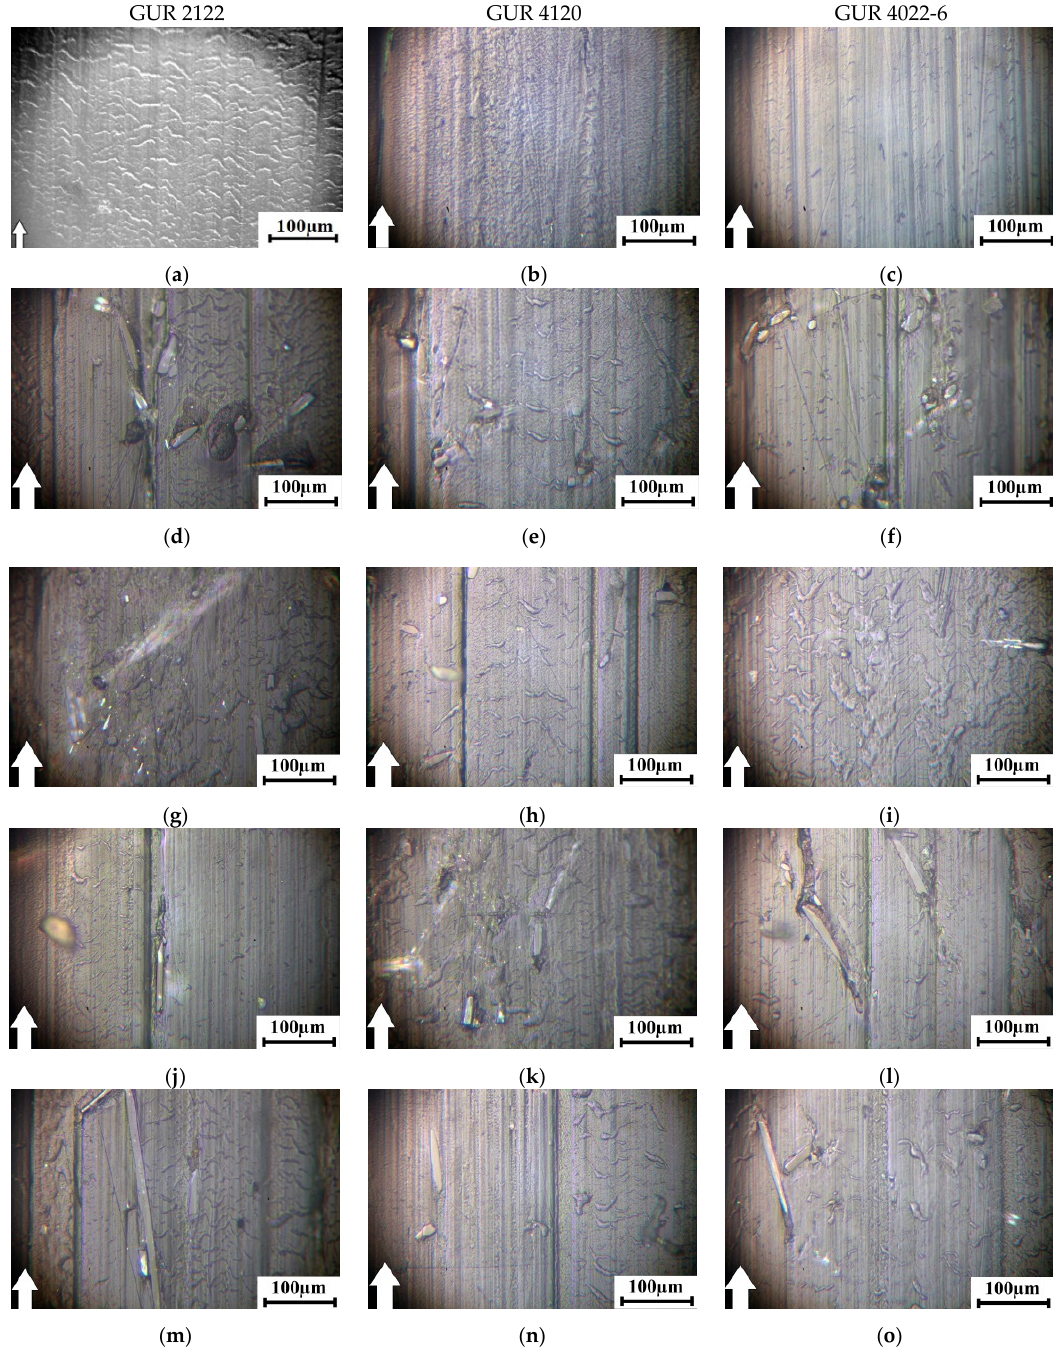
Figure 11. Optical images of the wear track surfaces of the neat UHMWPEE and its composites at 140 N × 0.5 m/s: based on the GUR 2122 powder ( a, d, g, j, m ); based on the GUR 4120 powder ( b, e, h, k, n ); based on the GUR 4022-6 powder ( c, f, i, l, o ).